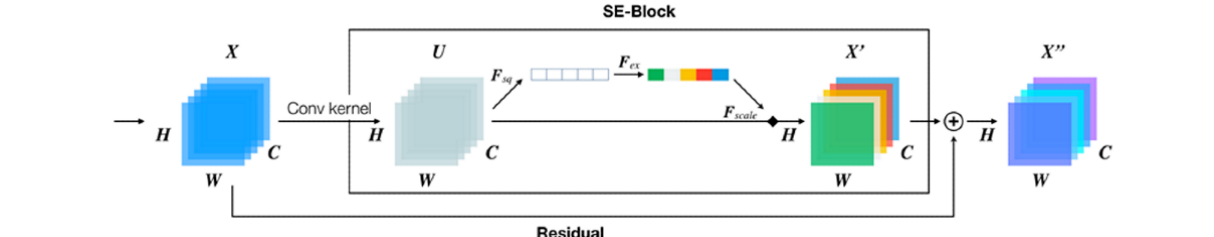
Figure 3. Model of the addition of the SE block to the residual convolutional block. Conv: convolutional; SE: